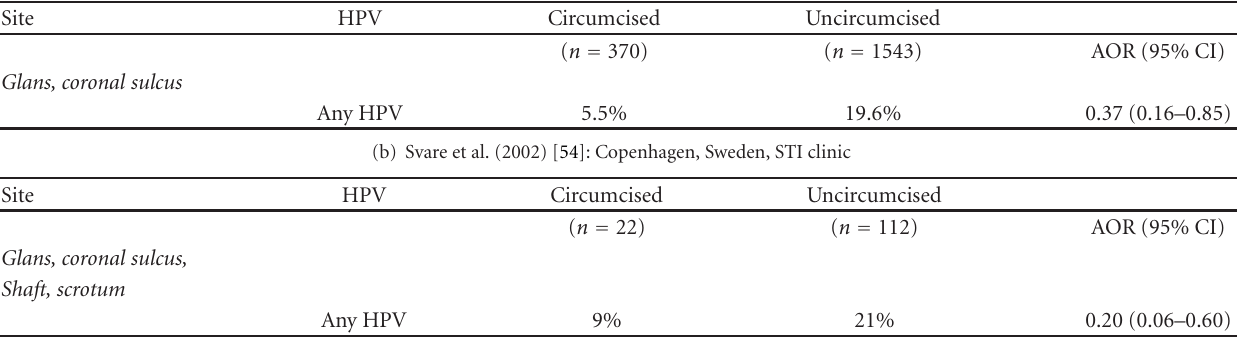
Table 1: Prevalence of HPV at di ff erent anatomical sites for circumcised and uncircumcised men in various studies in di ff erent